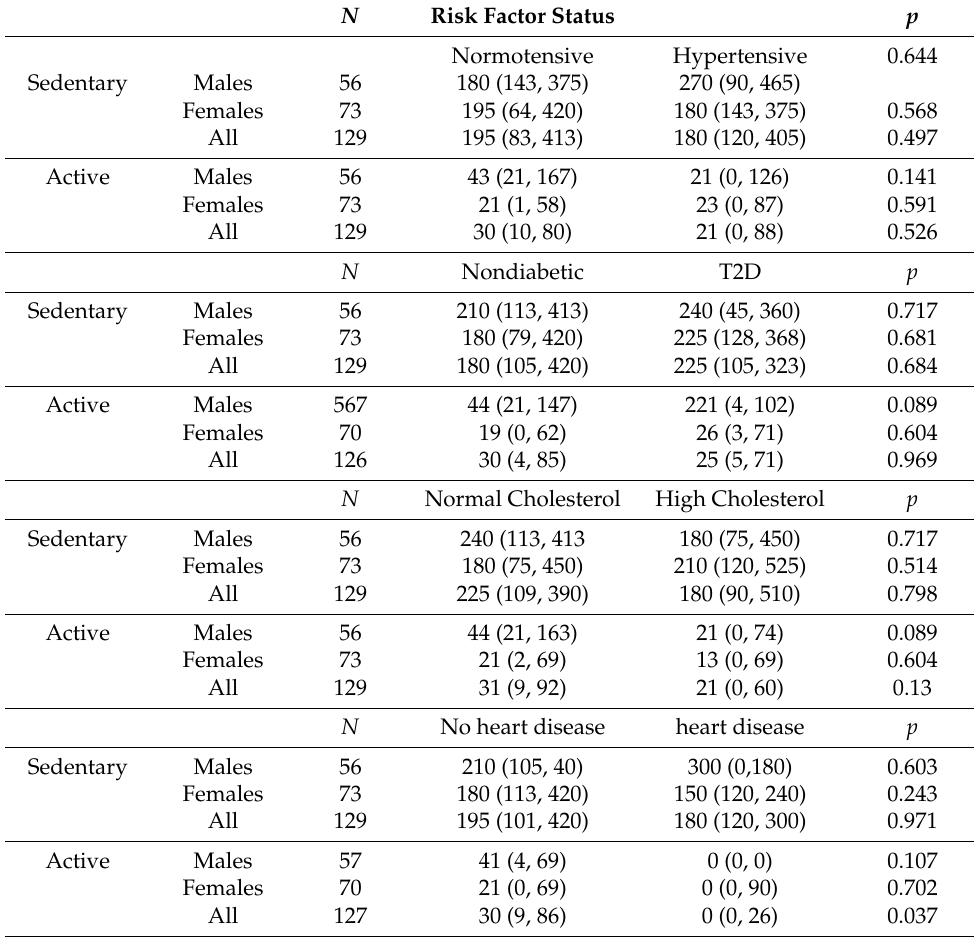
Table 4. Activity volume in minutes stratified by risk factor status and gender.